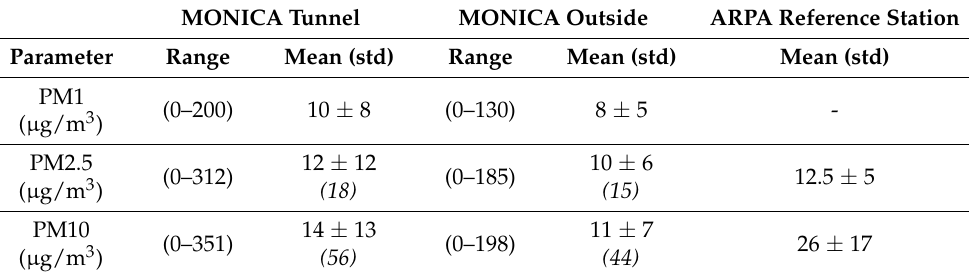
Table 3. PM concentrations estimations for MONICA monitors installed inside the tunnel, on the Viaduct San Paolo and by the regulatory station in the trimester April–June. Correction factors of 1.5 and 4, as from [33], have been used for PM 2.5 and PM 10 , respectively (in italic).